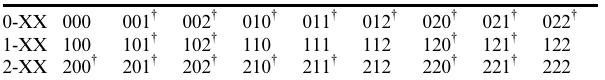
Table 2 . Potential and observed livelihood